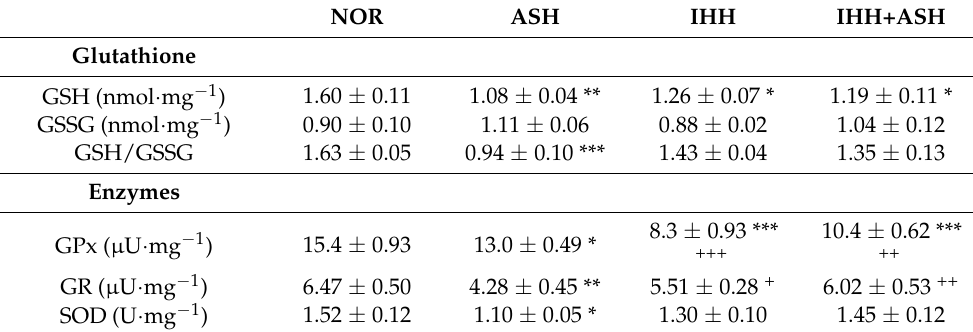
Figure 1. Oxidative stress markers in the brain. Units are expressed per milligram of protein. ( A ) TBARS, thiobarbituric acid-reactive substances; ( B ) AOPP, advanced oxidation protein products; and ( C ) NOx, nitric oxide species. Statistically significant differences between groups are presented with asterisks (*, vs. NOR) or crosses (+, vs. ASH). Two symbols indicate p < 0.01 and three symbols p < 0.001. F-values after running one-way ANOVAs with Bonferroni’s post hoc multiple comparison tests were: F = 10.83 (TBARS), F = 12.42 (AOPP) and F = 6.33 (NOx). Animal experimental groups are abbreviated as NOR, normoxic; ASH, acute severe hypoxia; IHH, intermittent hypobaric hypoxia; IHH+ASH, intermittent hypobaric hypoxia followed by acute severe hypoxia. Table 1. Antioxidant activity and gluthatione system in the brain.